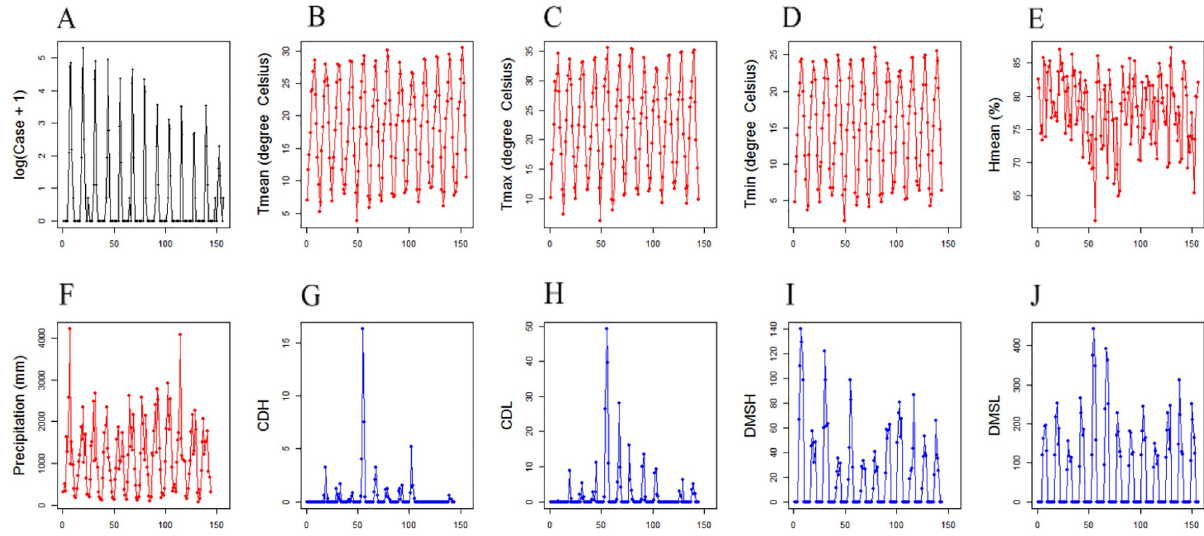
Fig 3. Monthly time series plots in Chongqing from 2007 to 2019. Monthly time series of the JE incidence (A), the mean air temperature (B), the maximum air temperature (C), the minimum air temperature (D), the average of relative humidity (E), the precipitation (F), the C . tritaeniorhynchus density in human houses (CDH) (G), the C . tritaeniorhynchus density in livestock sheds (CDL) (H), the density of all mosquito species in human houses (DMSH) (I) and the density of all mosquito species in livestock sheds (DMSL) (J) respectively.